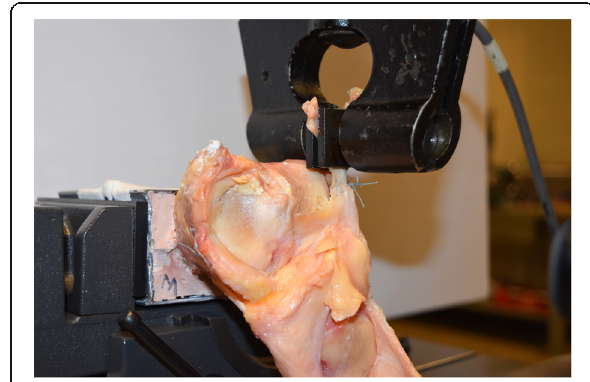
Fig. 3 Lateral view of Instron testing for left cadaver knee lateral meniscus. A hydraulic clamp is applied to the posterior horn with the tibia potted and anterior horn and capsular attachments maintained